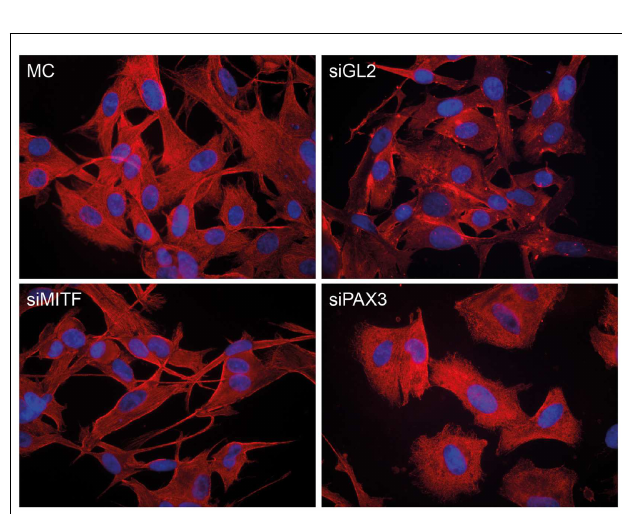
FIGURE 6 | Knockdown of PAX3 or MITF results in differential morphological effects in NZM15 melanoma cells . NZM15 melanoma cells were grown in media without any transfection (MC), or transfected with siRNA to luciferase (siGL2) as a non-targeting control, siRNA to MITF (siMITF), or siRNA to PAX3 (siPAX3) and then stained after 48h with β -tubulin antibody.